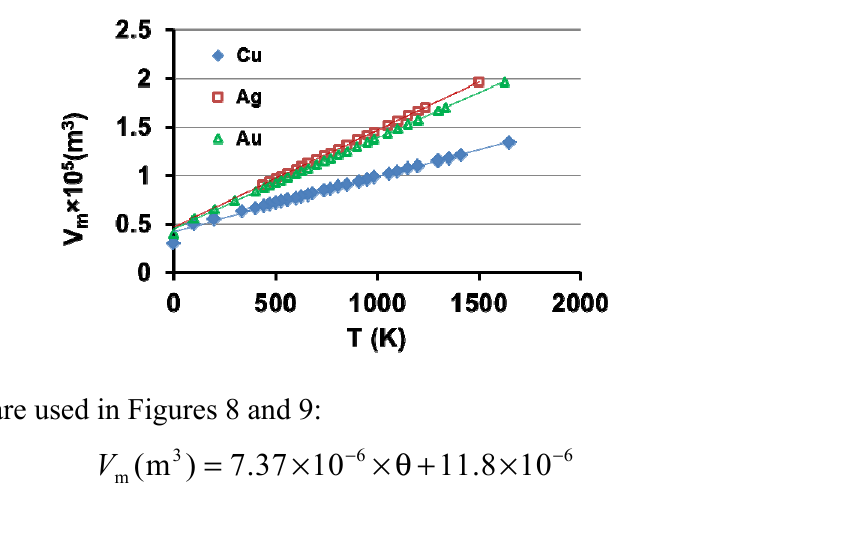
Figure 9. The supercluster molar volume change of Cu, Ag and Au. The supercluster molar volume change with the critical radius R * (being a hidden variable) is plotted as 2ls a function of their formation temperature in Kelvin up to T . Each point corresponds to m a supercluster of radius R * and to an n -atom 2ls